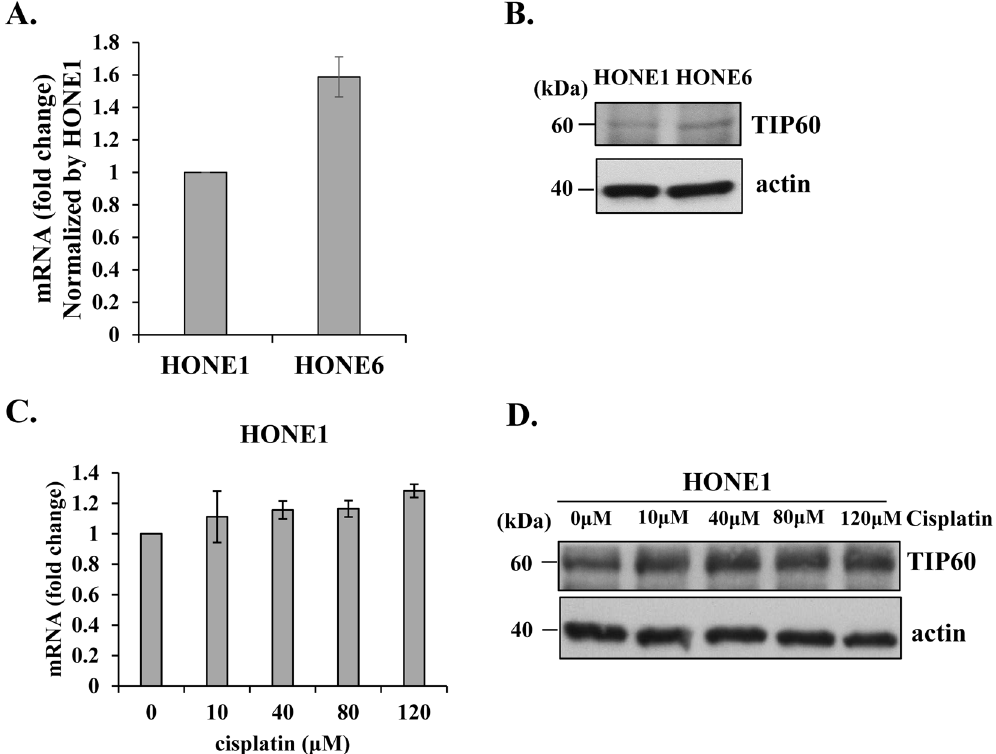
Figure 1. Chemoresistant HONE6 cells exhibit higher expression levels of TIP60 than cisplatin-sensitive HONE1 cells. The expression levels of TIP60 in HONE1 and HONE6 cells were determined by qRT-PCR ( A ) and Western blotting ( B ). The expression level of TIP60 in HONE6 cells was normalized by the level in HONE1 cells. ( C ) HONE1 cells were treated with various concentration of cisplatin for three hours. The expression level of TIP60 was determined by qRT-PCR and by Western blotting ( D ). Each value derived from qRT-PCR represents the mean ± standard deviation from at least three experiments. Full-length blot is presented in Supplementary Figure